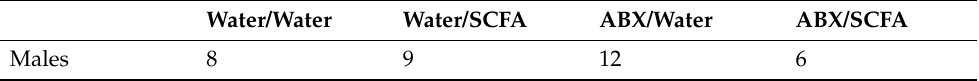
Table 3. Animal numbers per treatment group for fentanyl intravenous self-administration in short- chain fatty acid (SCFA) supplementation with or without antibiotics